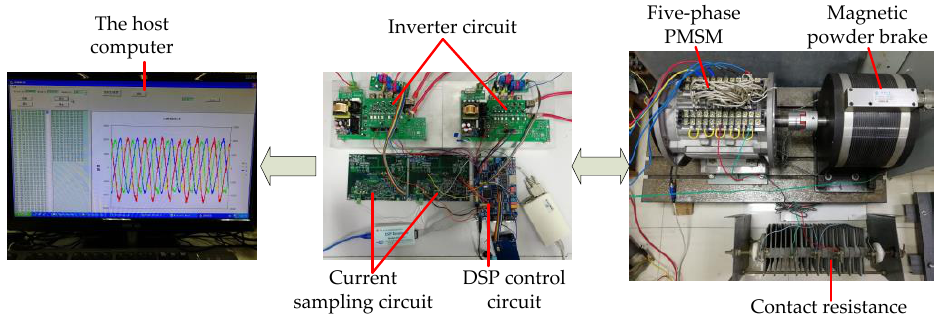
Figure 20. The experimental platform of five-phase PMSM.